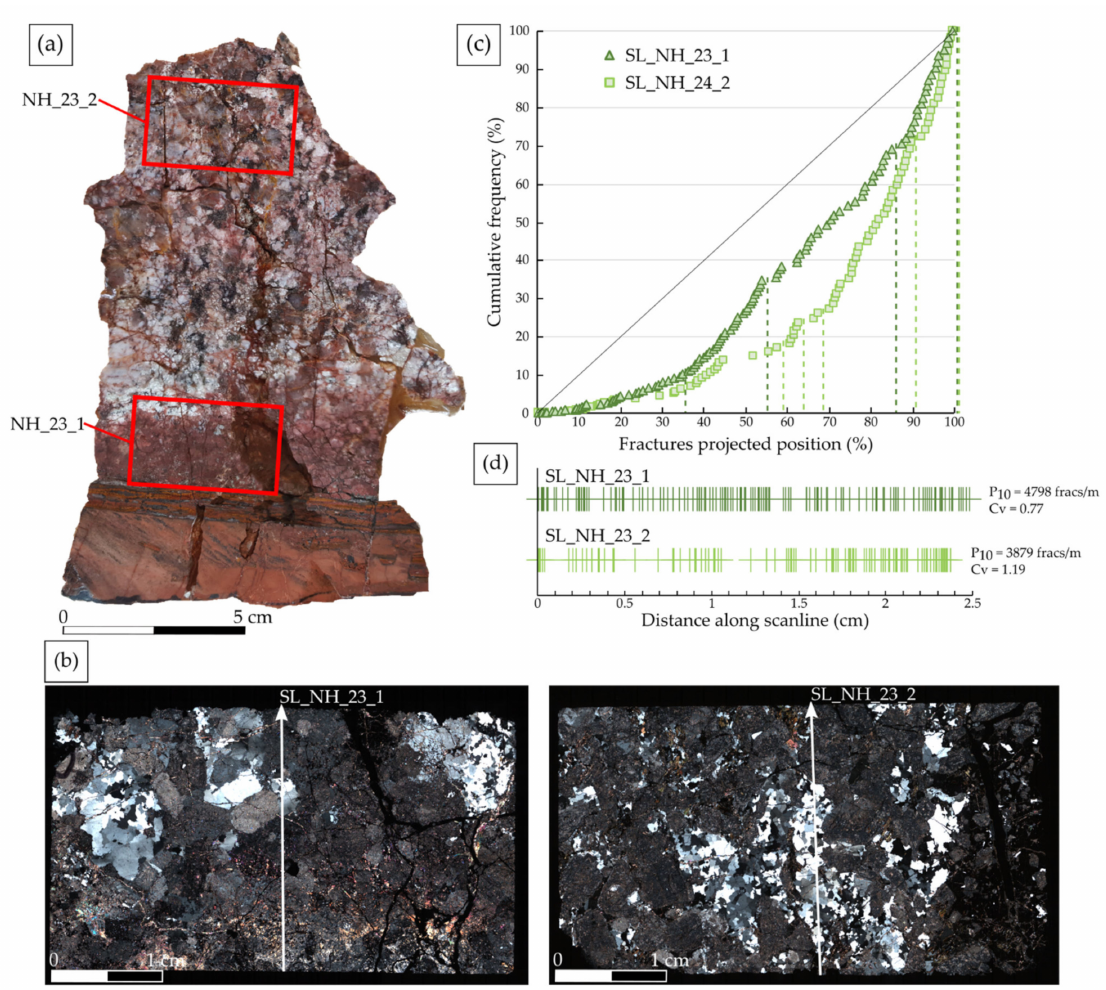
Figure 13. ( a ) Thin section location on the sample NH_23. ( b ) Thin section mosaics showing the position and orientation of the scanlines. ( c ) Plots of the cumulative frequency percentage against distance percentage for each scanline. The diagonal represents a uniform distribution. Dashed lines indicate a zone where a rapid increase of the number of fractures is observed (slope threshold >2). ( d ) Stick plots showing the position of the fractures along the scanlines and for which the fracture density (P 10 ) and the coefficient of variation (Cv) are